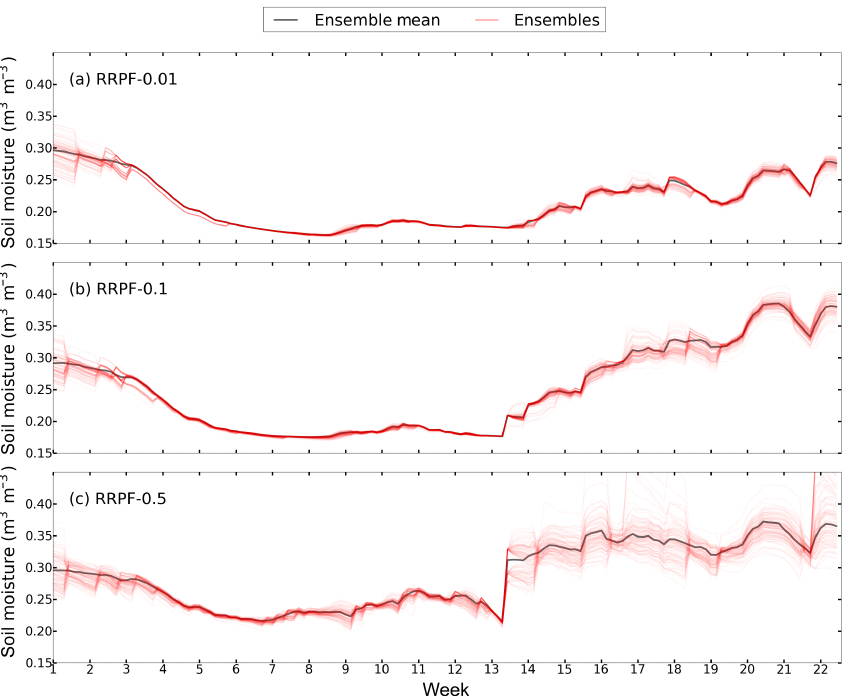
Figure 9. Soil moisture trajectories of the N = 100 ensemble members at 50cm depth for the 5-month assimilation period (weeks 1 to 22) of the Rollesbroich site using VIC-3L and (a) RRPF-0.01, (b) RRPF-0.1, and (c) RRPF-0.5. The solid black line signifies the ensemble mean soil moisture